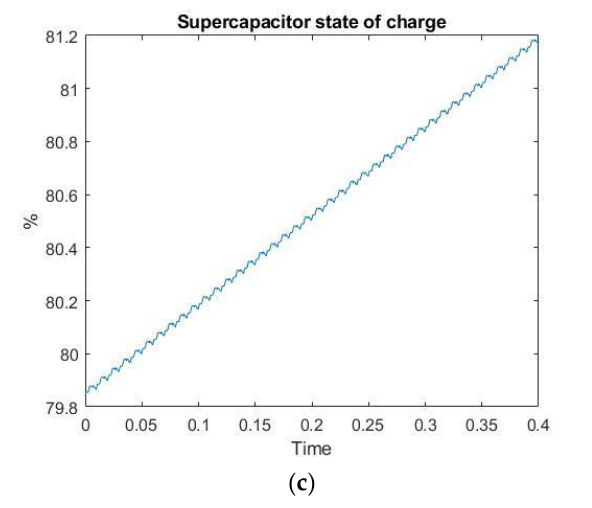
Figure 11. Charge of the supercapacitor: ( a ) current; ( b ) voltage and ( c ) state of charge.